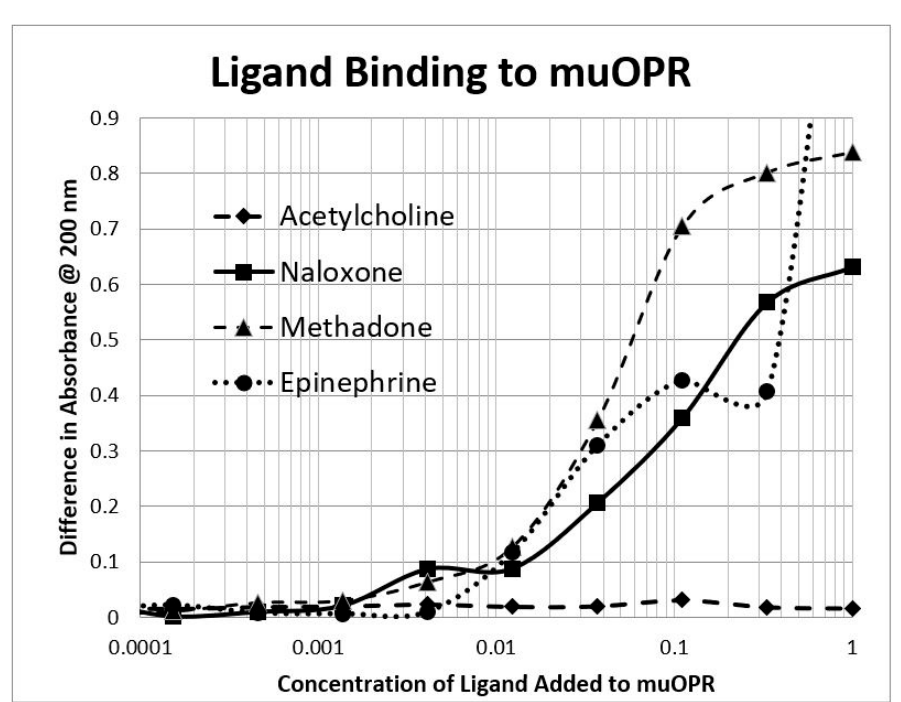
Figure 10. Effect of serial additions of naloxone at increasing concentrations on the UV spectrum of intact mu opioid receptors (muOPRs). Compare with Figures 7–9.